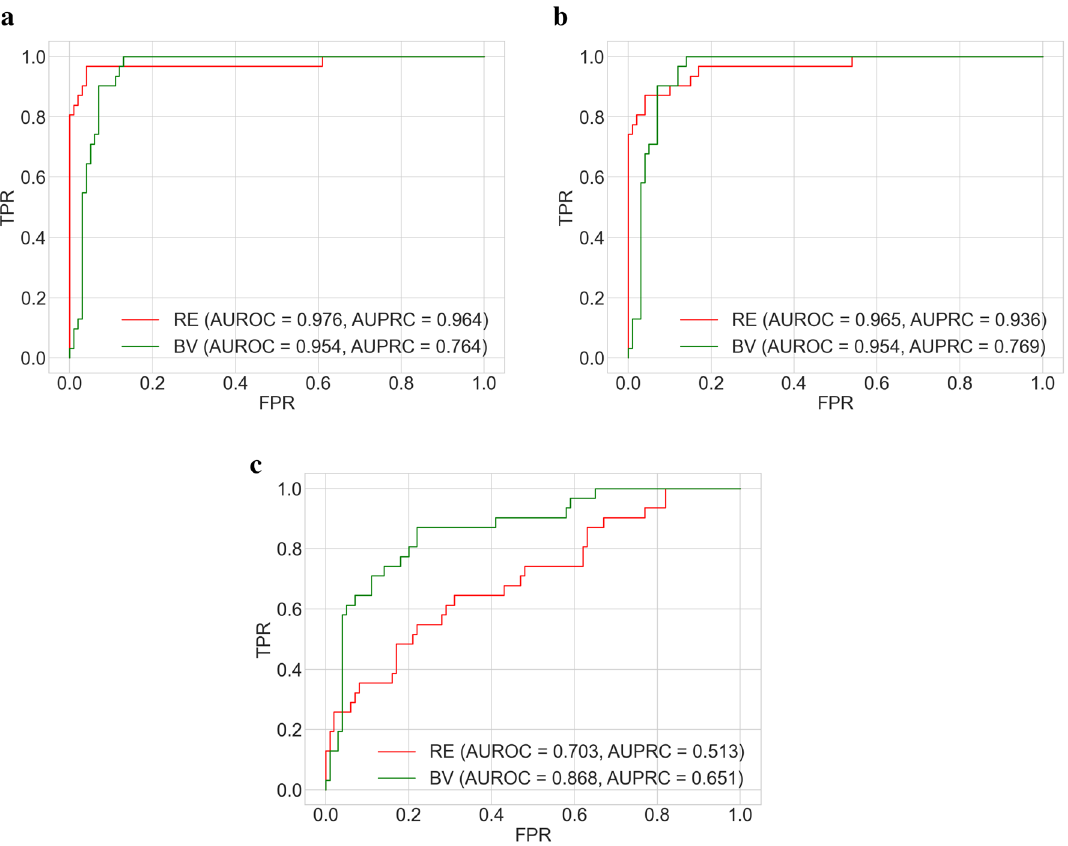
Fig. 8 ROC curves and AUROC, AUPRC scores for Pro-SiVIC dataset (RE—the reconstruction error approach, BV—the bottleneck-values approach): a for the original images, b for the modified images, c for the greyscaled